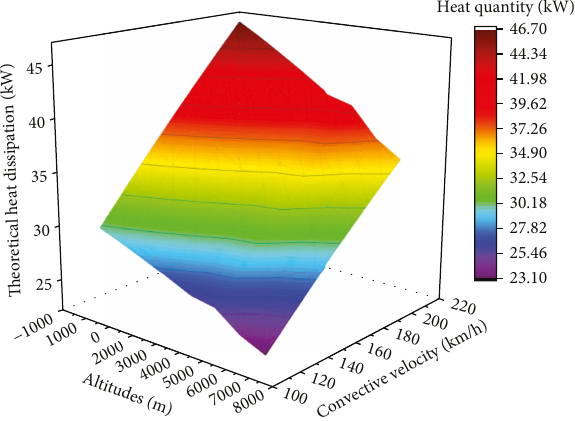
Figure 5: Theoretical heat dissipating capacity at high altitudes. Maximum wind speed is 11.3 m/s